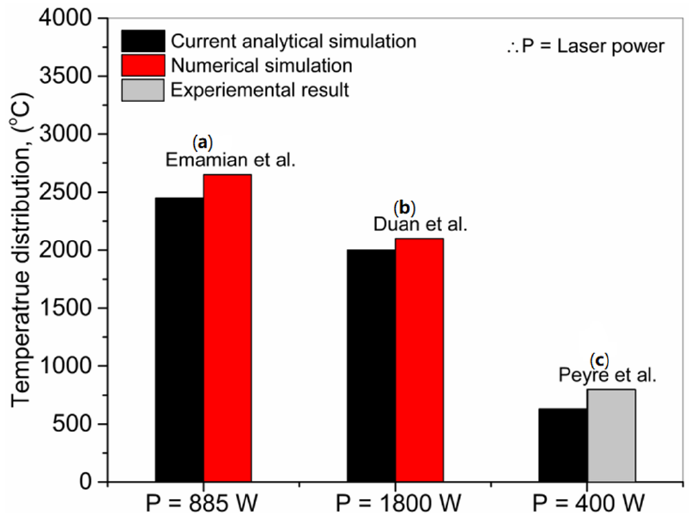
Figure 7. Comparison of current analytical with ( a ) numerical simulation for Fe-TiC depositions on the carbon steel substrate [34], ( b ) numerical simulation of 12Cr Ni2 alloy steel powder depositions on 45 steel substrate [35], and ( c ) experimental results for Ti6Al4V titanium alloy powder deposition on Ti6Al4V titanium alloy substrate [36].